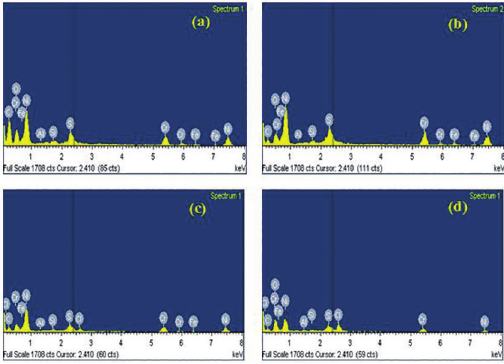
Figure 7. Chemical composition by EDS of (a) 3% reinforcement, (b) 6% reinforcement, (c) 9% reinforcement, (d) 12% reinforcement.